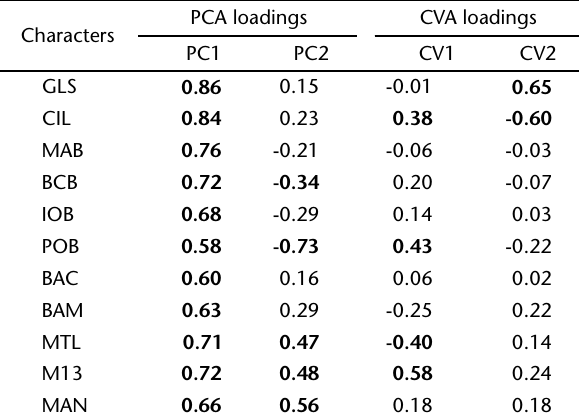
Table IV. Vector correlation coefficients (“loadings”) between original variables and principal components (PC1 and PC2) and between original variables and canonical variates (CV1 and CV2) for South American samples of Myotis albescens . Numbers in bold indicate vector correlations with magnitudes larger than